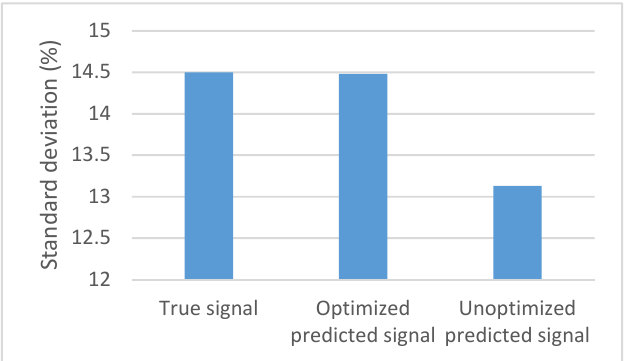
Figure 9. Data distribution of the different methods.